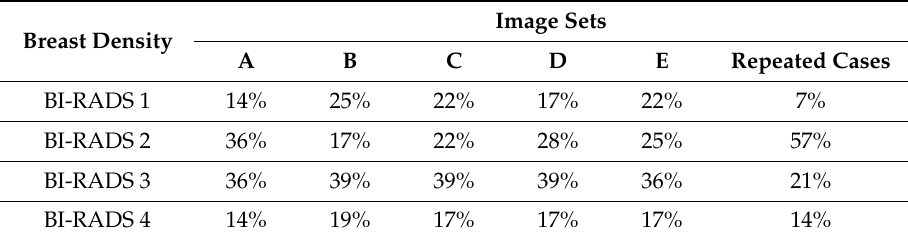
Table 1. The distribution of BI-RADS categories within each set without the repeated cases and for the repeated